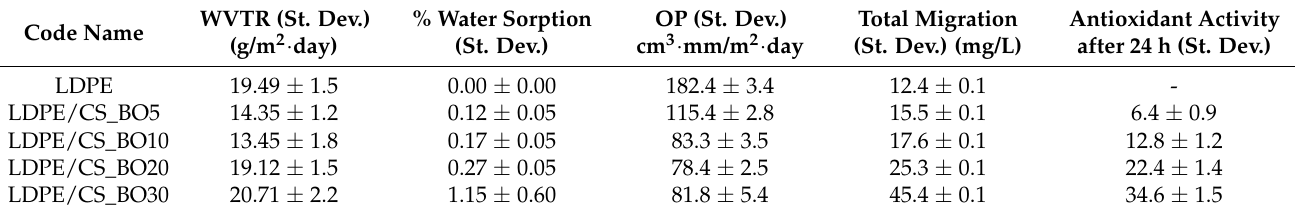
Table 2. Water vapor transmission rate (WVTR), water sorption, oxygen permeability (OP), total migration, and antioxidant activity values of all tested LDPE/CS_BO active films. WVTR (St. Code Name